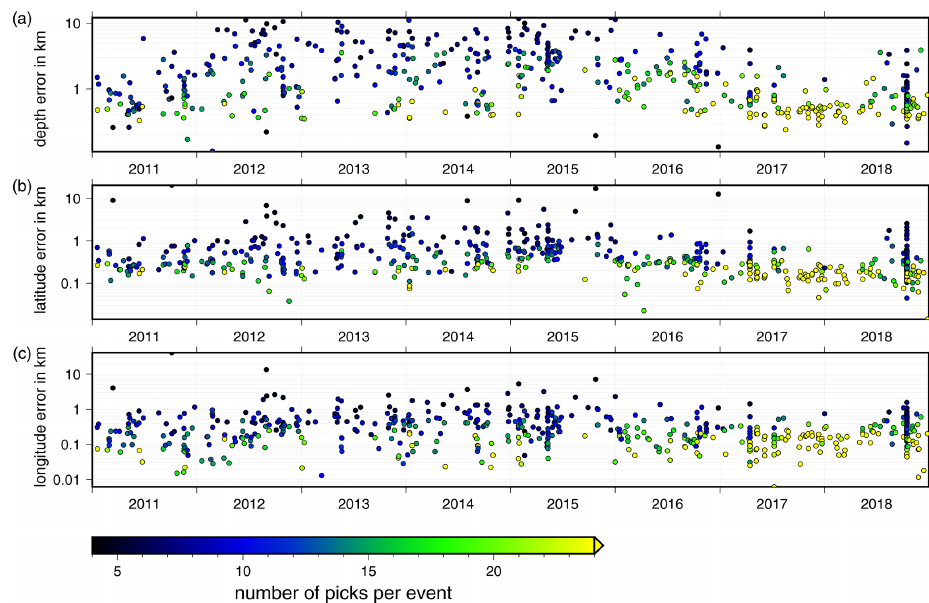
Figure 5. Errors calculated from the 68% confidence ellipsoid from NLL with L2 (L2-rms likelihood function) for each event in the combined catalog for (a) depth, (b) latitude and (c) longitude. The errors are color-coded depending on the number of picks, with dark colors indicating fewer picks and bright colors indicating many picks. Hypocenters with many observations are determined with smaller errors in depth and lateral